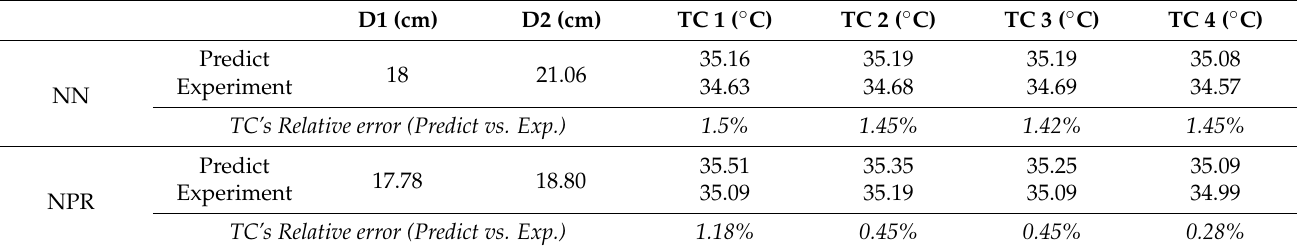
Table 6. Optimization results for the two regression models (NN and